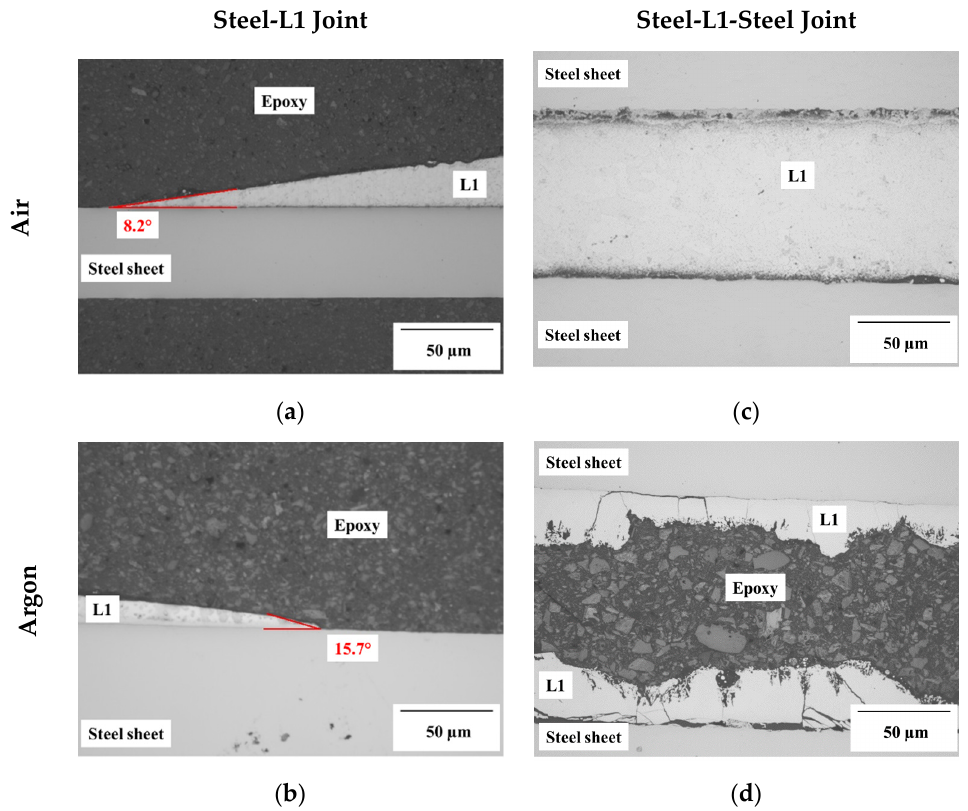
Figure 5. Light microscopy images of steel–L1 and steel–L1–steel brazed joints in air and Ar atmosphere. ( a ) Steel–L1 joint zone in air, ( b ) steel–L1 joint zone in Ar for contact angle